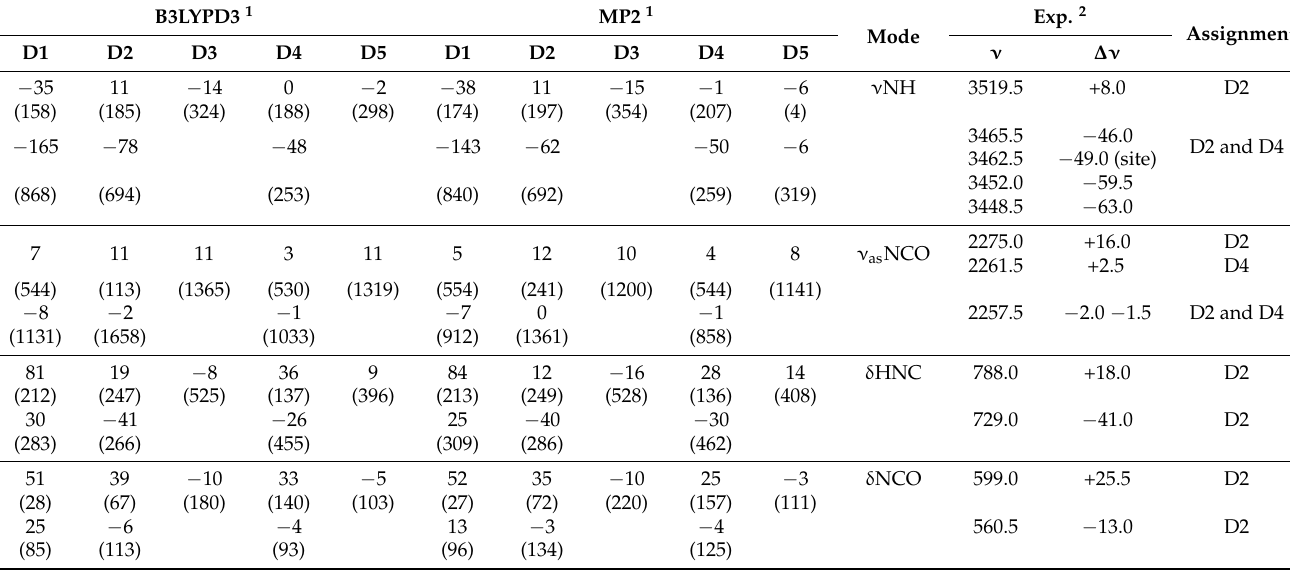
Table 4. Selected unscaled wavenumber shifts (cm − 1 ) of vibrational modes calculated for the HNCO dimers using the B3LYPD3 and MP2 methods with the 6-311++G(3df,3pd) basis set and compared to the experimental results. The calculated infrared intensities (km mol − 1 ) of the bands are given in